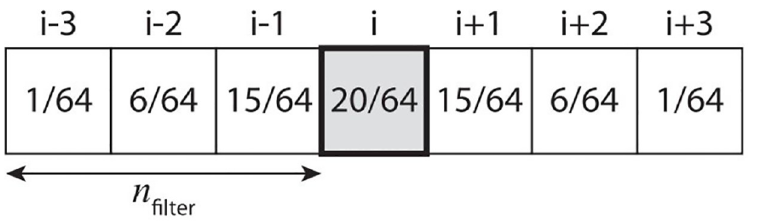
Fig 5. Separable binomial filter with size n filter = 3. The acceleration value ( i , j ) shown in the center is the weighted sum of the neighboring